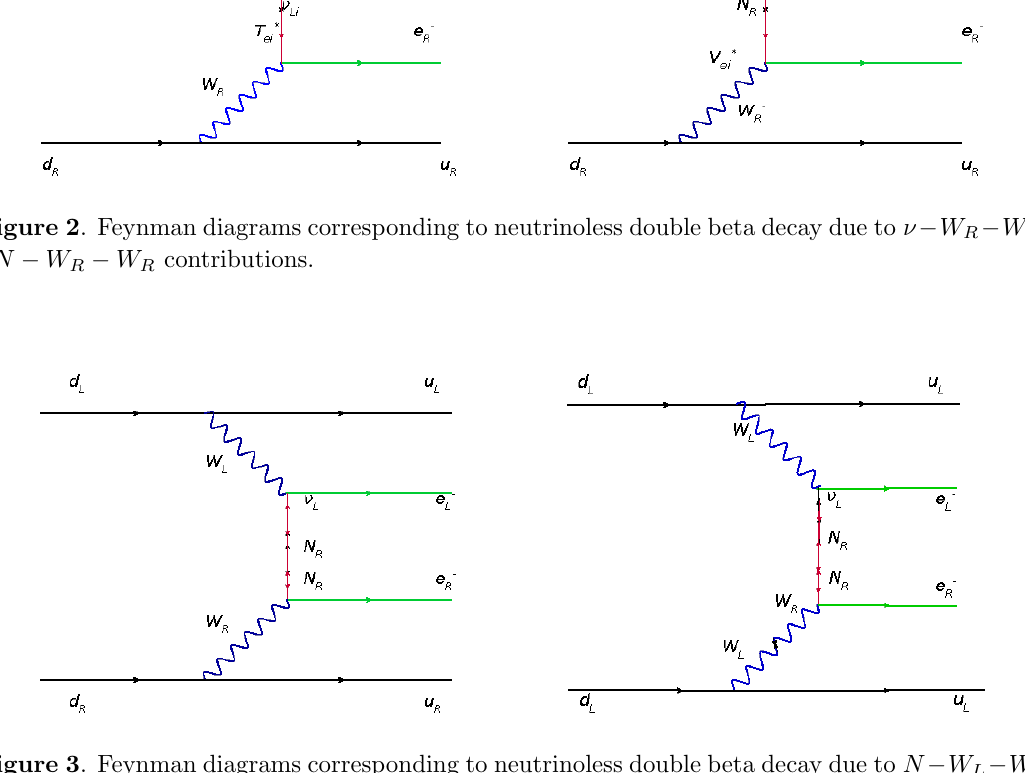
Figure 3 . Feynman diagrams corresponding to neutrinoless double beta decay due to N (cid:0) W L (cid:0) W R mediation with heavy-light neutrino exchange and W L (cid:0) W R mixing ( (cid:21) and (cid:17) contributions).